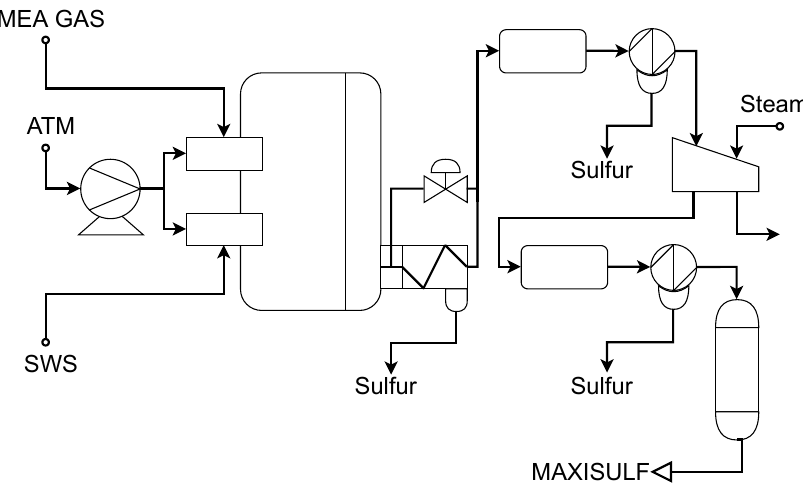
Figure 10. Simplified scheme of a SRU line based on [65].